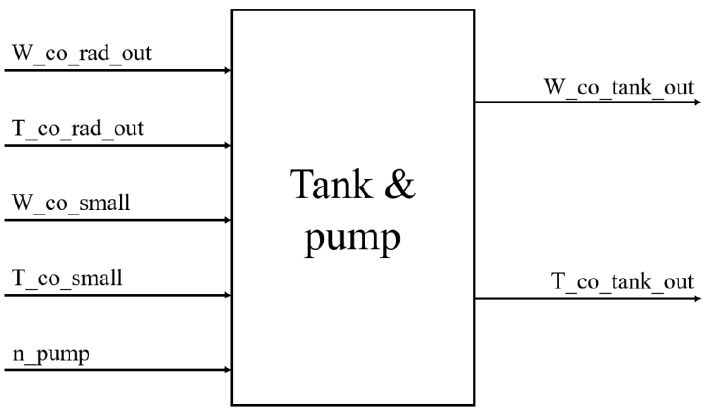
Figure 9. The input and output of the tank and pump model.